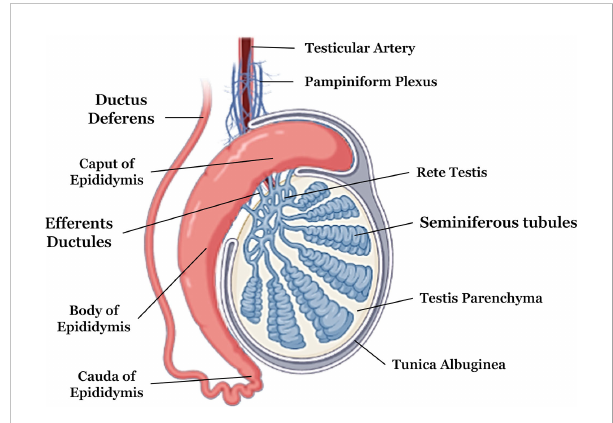
FIGURE 1 Anatomical description of testicular and epididymal structures. Adapted from